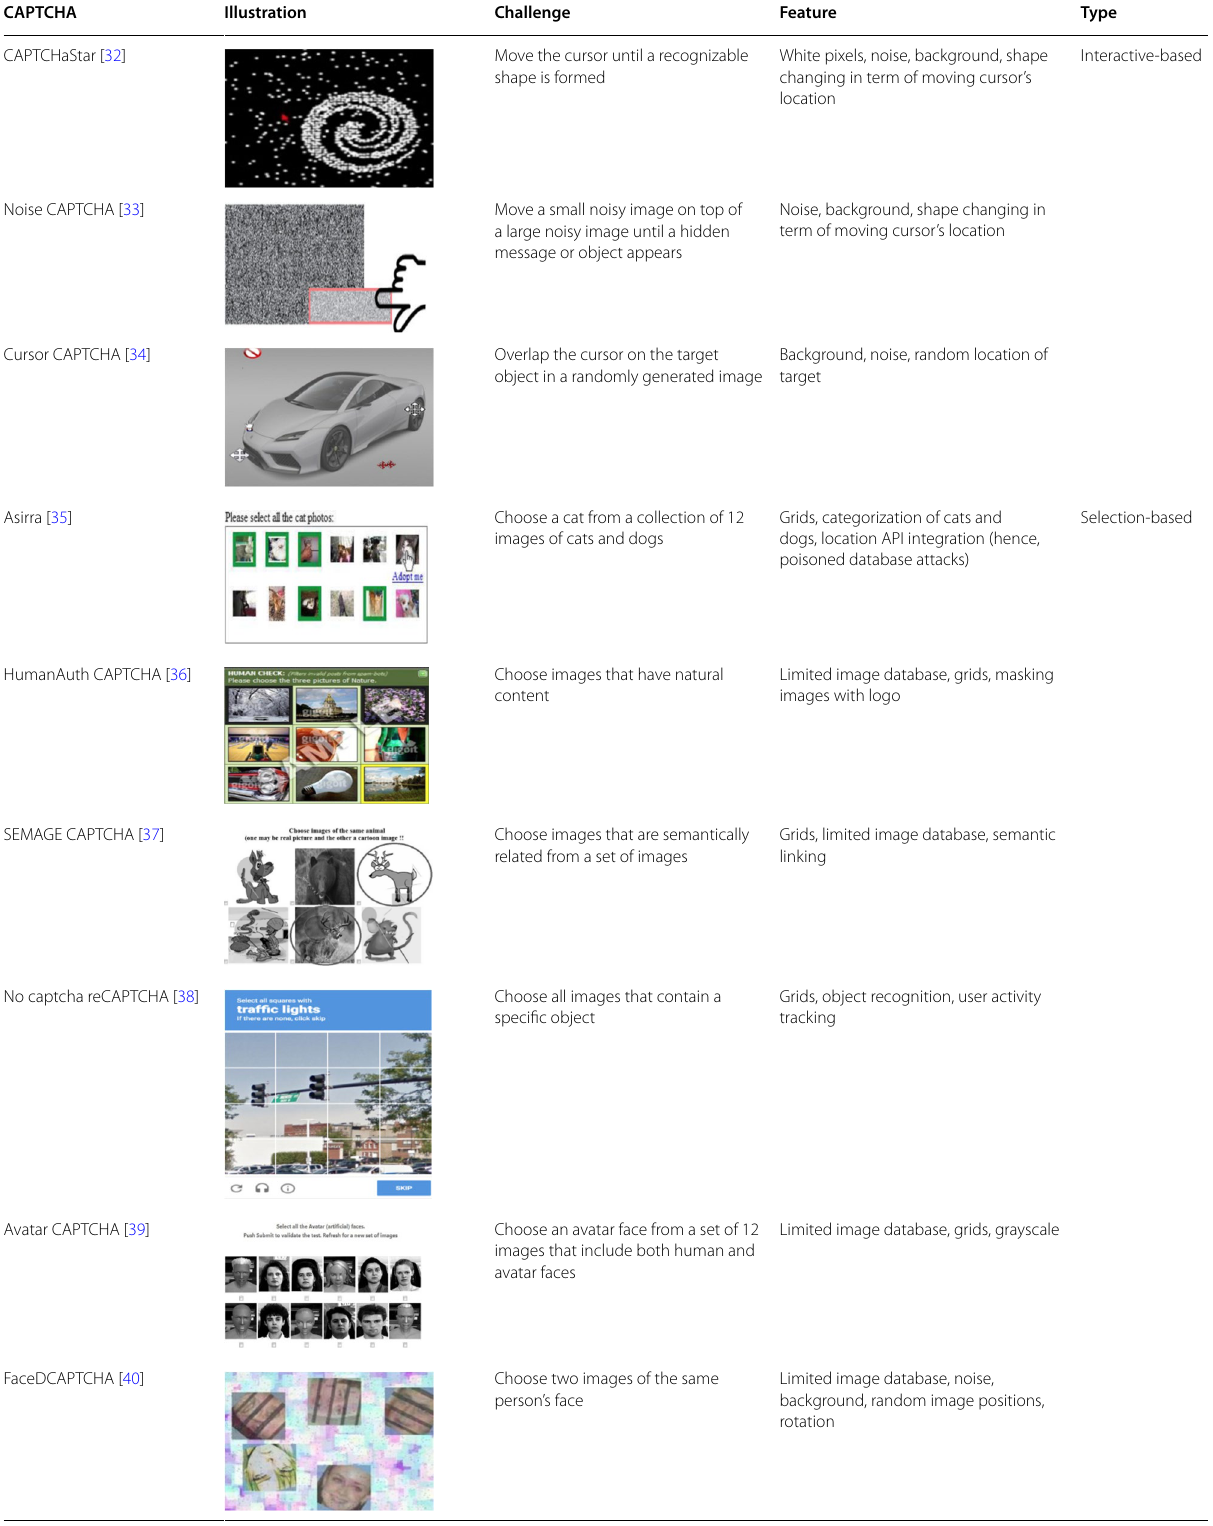
Table 2 Typical image-based